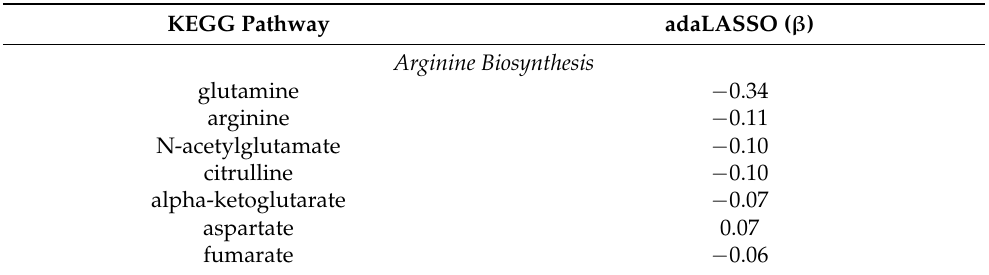
Figure 2. Pathway Analysis for FEV 1 -annotated pathways indicate pathways with FDR < 0.1. The colors for each pathway refer to the − log 10 ( p ) of the over-representation raw p -value (unadjusted for multiple comparisons) with red to yellow indicating a higher to lower − log 10 ( p ) values. The pathway impact represents the importance of the matched metabolites normalized by the importance of all metabolites in the pathway. Table 4. Metabolites and adaLASSO Coefficients in Significant KEGG Pathways (FDR <